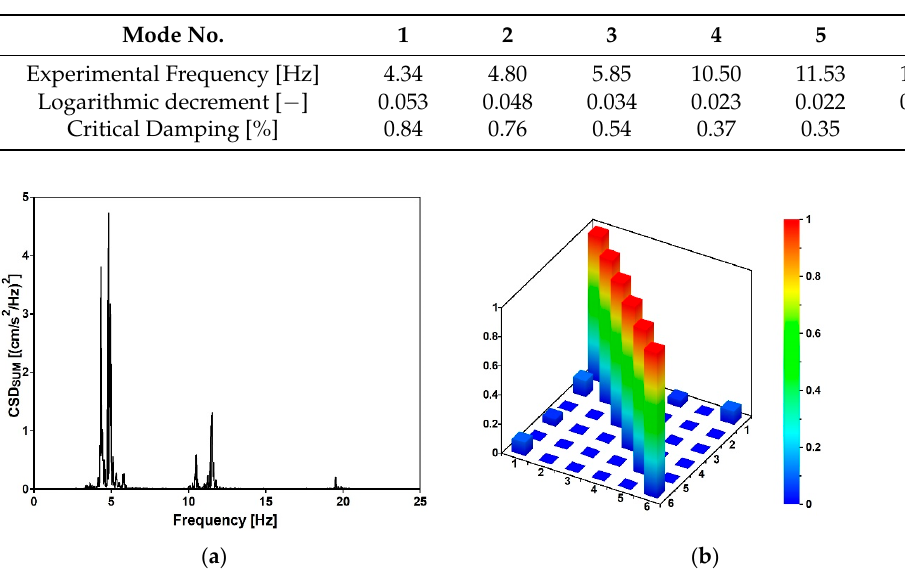
Figure 14. ( a ) Natural frequency estimator: CSD values vs. frequency value; ( b ) 3D visualization the AutoMAC values.